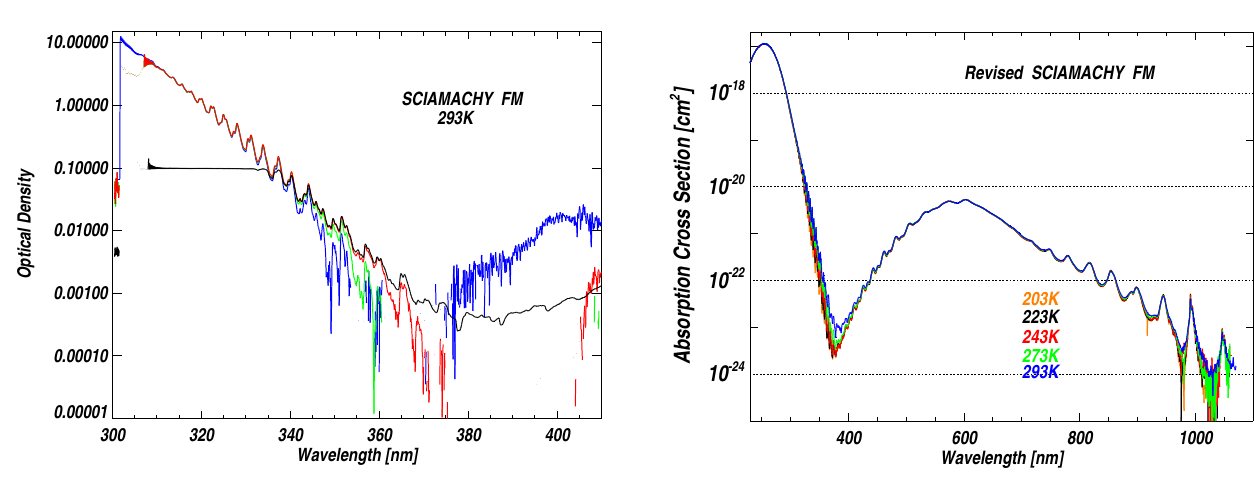
Fig. 4. Revised temperature-dependent ozone absorption cross- section spectra measured with the SCIAMACHY spectrometer (230–1070nm). The cross-section data cover the Hartley, Huggins, Chappuis and the Wulf bands and were recorded at 203K, 223K, 243K, 273K, and 293K.